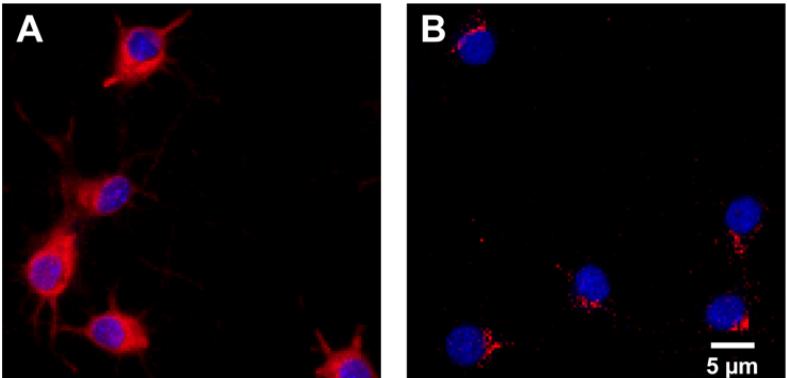
Figure 2. IRAP expression. Representative images of the expression of insulin-regulated aminopep- tidase (IRAP) shown in red and cell nuclei stained with 4 ′ ,6-diamidino-2-phenylindole (DAPI) shown in blue in ( A ) untreated primary hippocampal and ( B ) cortical cells. IRAP was targeted using primary antibody rabbit anti-IRAP and secondary antibody Alexa 568 anti-rabbit. The images were acquired using ImageXpress (Molecular Devices) mounted with a 20 × objective.